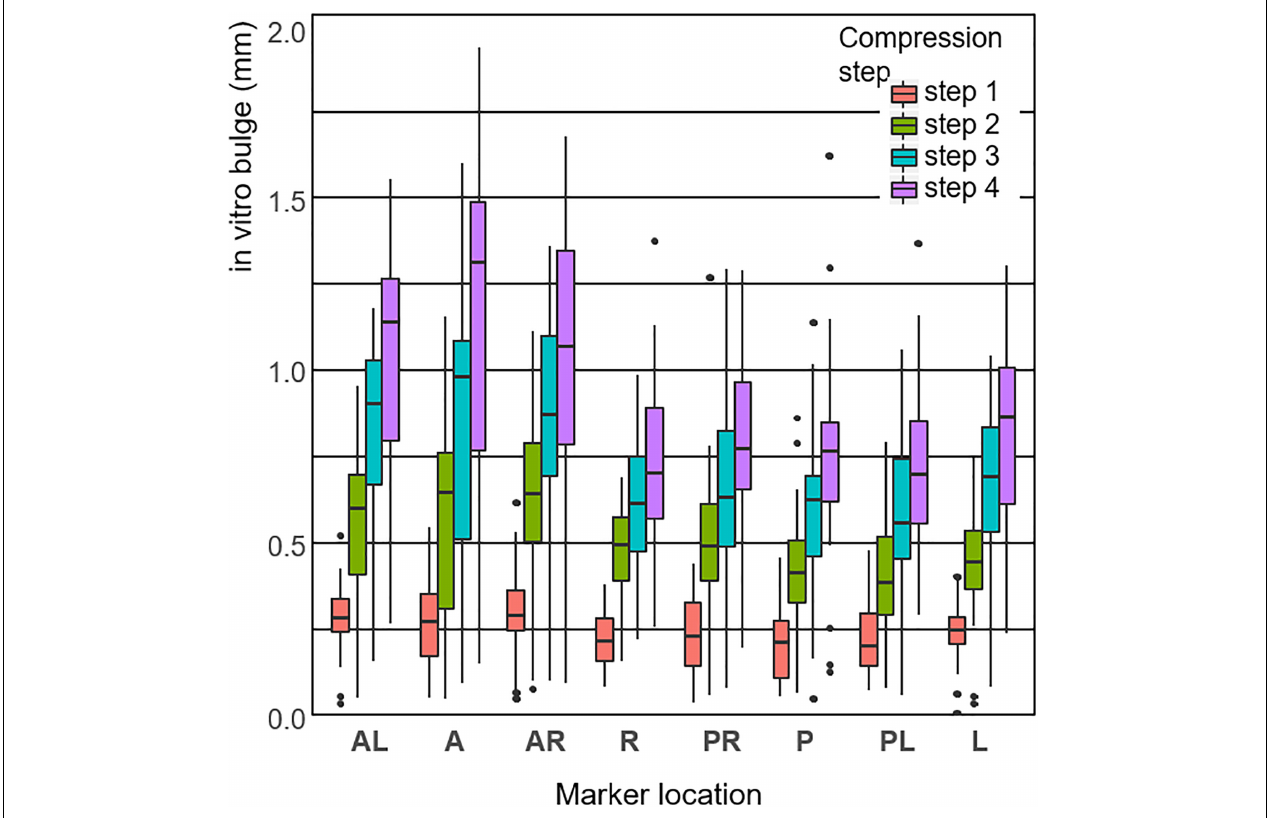
FIGURE 6 | Box-plot distribution of the in vitro surface disc bulge, measured by marker location (defined in Figure 2 ) and load